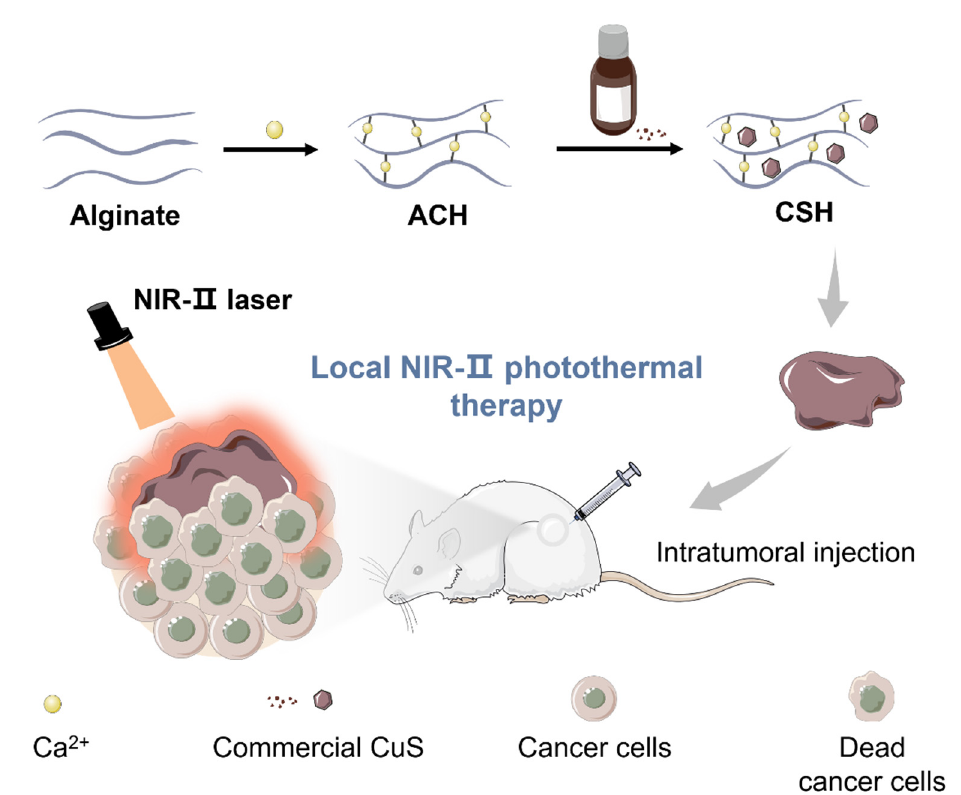
Figure 1. Schematic representation of the synthesis of CSH as a PTT agent for local NIR-II PTT in vivo.